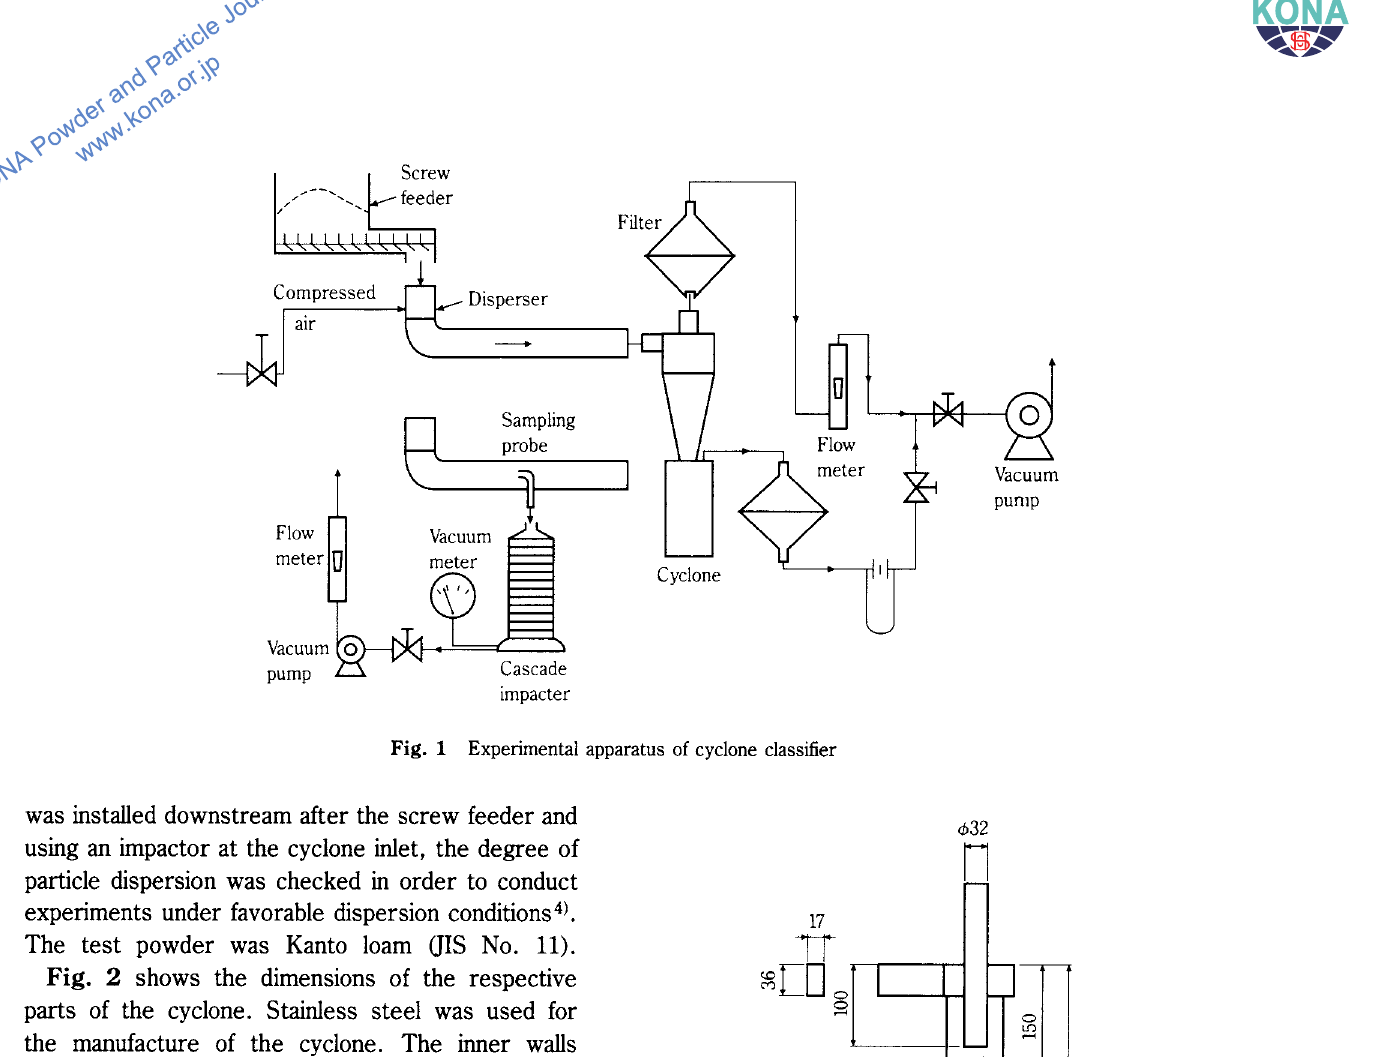
Fig. 2 Dimensions of the cyclone